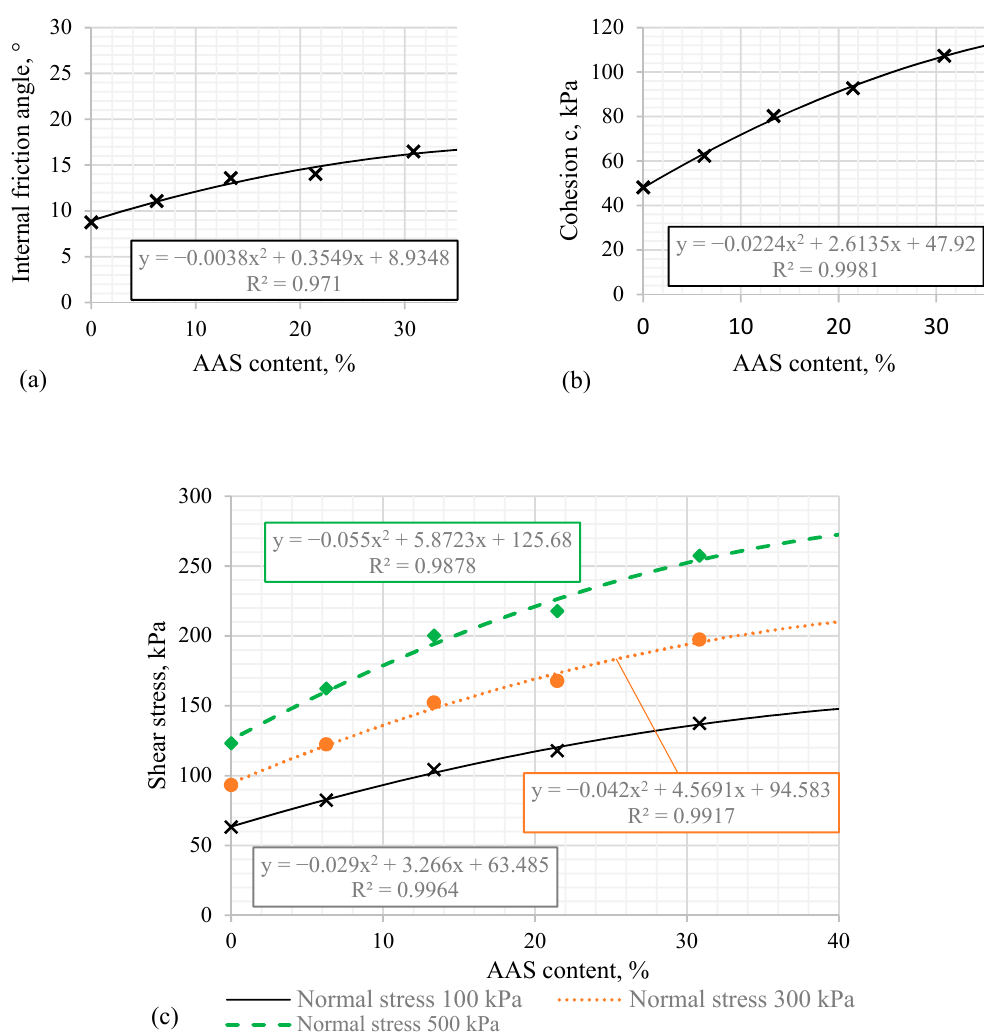
Figure 6. The AAS influence on the internal friction angle ( a ), cohesion ( b ) and shear stress of cylindrical samples ( c ).